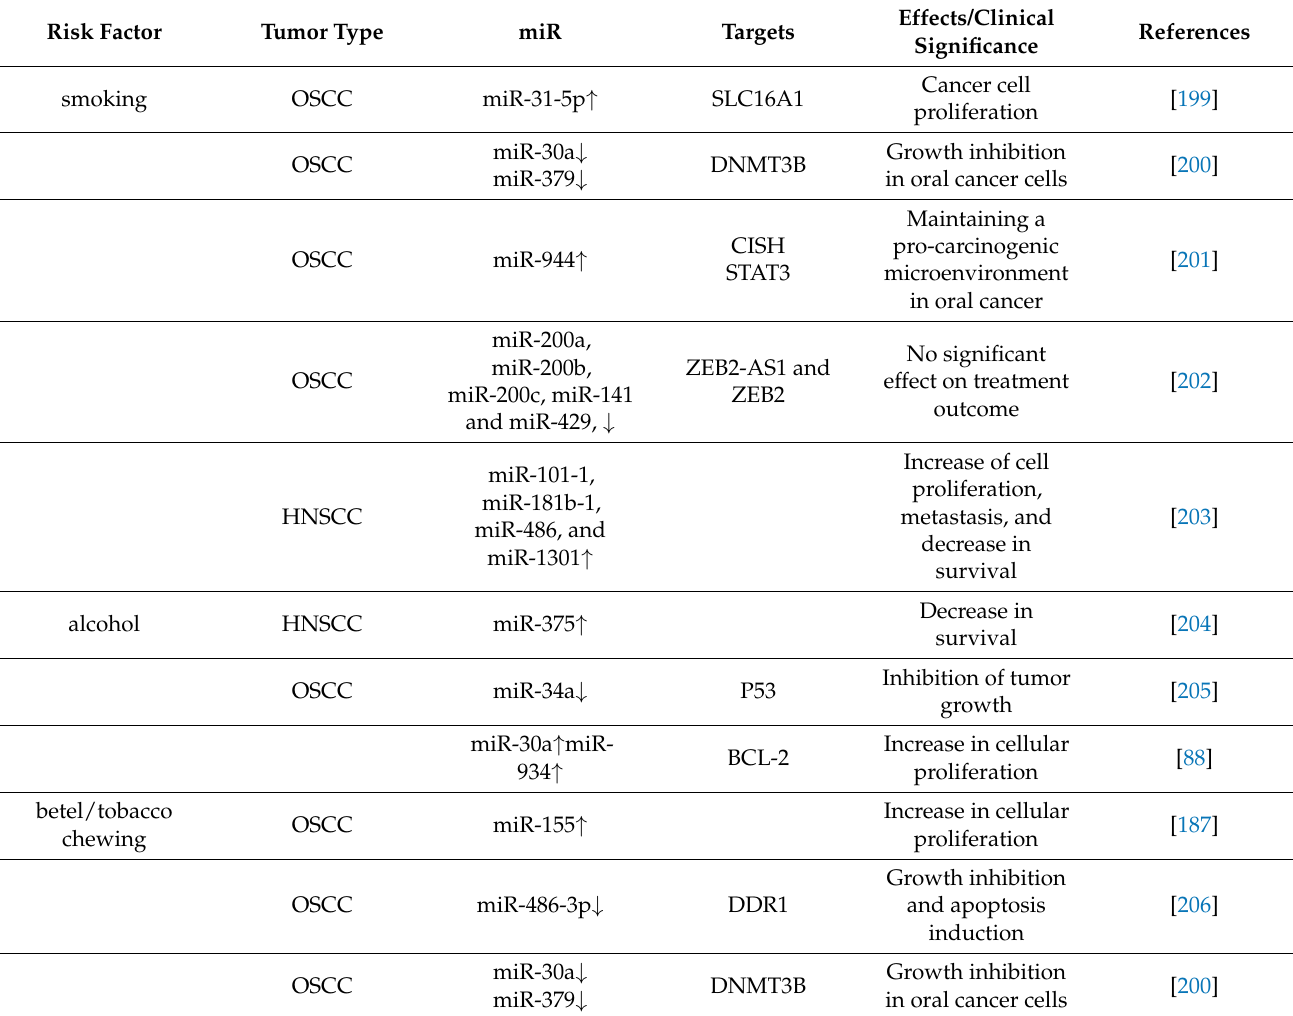
Table 1. The main miRNAs related to risk factors in oral